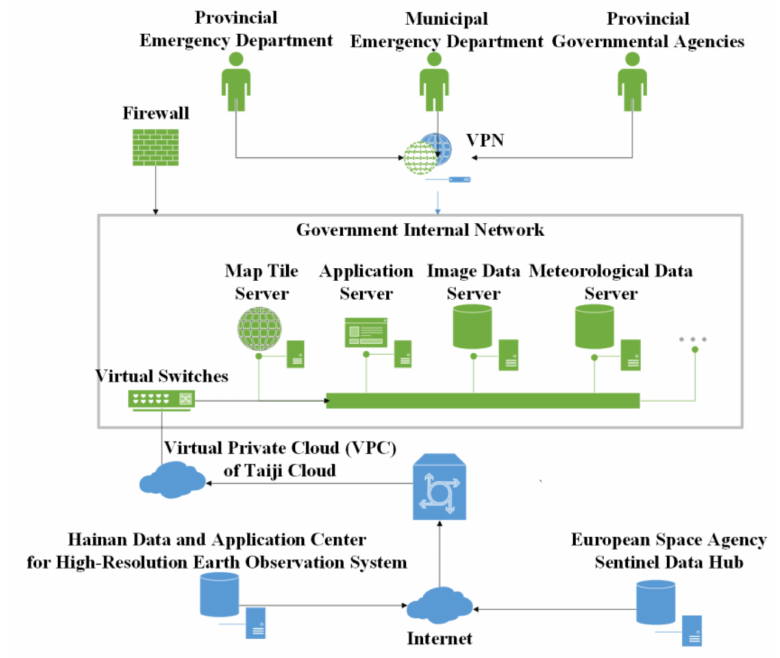
Figure 4. System deployment